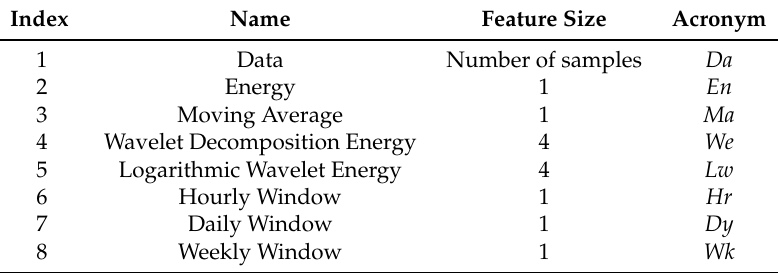
Table 2. Feature